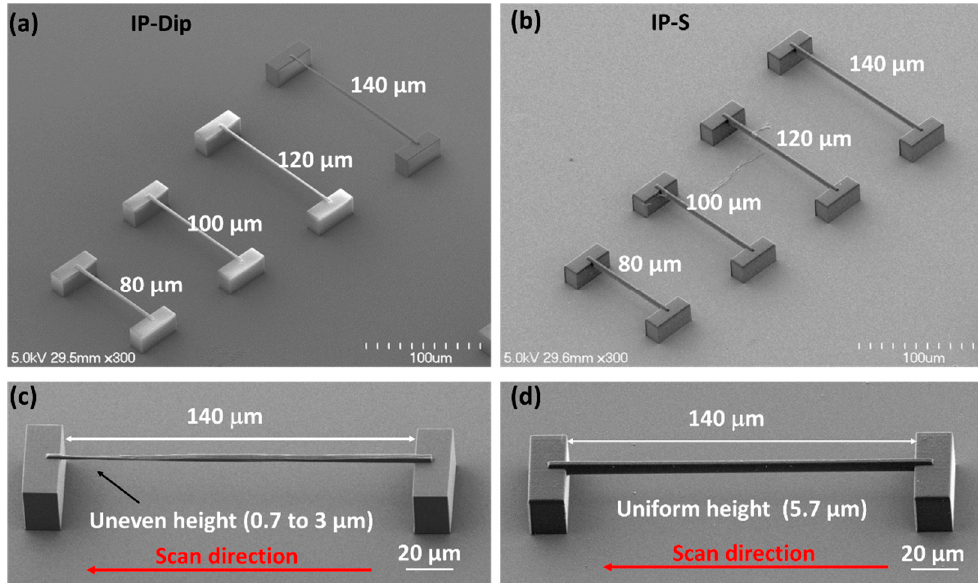
Figure 5. Simply supported beam structures fabricated in ( a , c ) IP-Dip and ( b , d ) IP-S resin. The scan direction was from right to left, as indicated by the arrow. The average laser power was 15 mW, and the scanning speed was 10 mm/s; see the text for further details.